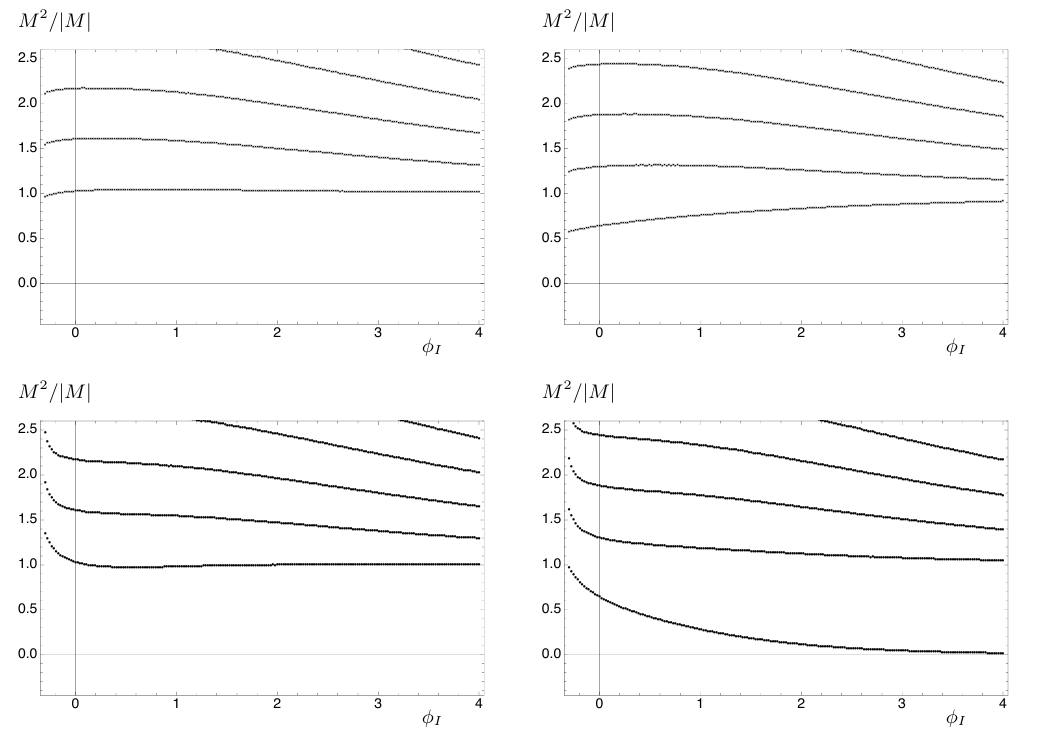
Figure 6 . Mass spectrum, with M 2 = − q 2 , of the spin-1 particles coming from the 2 -forms in five dimensions, as a function of the parameter φ , and normalised to the lightest tensor mode. The I markers are chosen to match the representations under SO(4) . Left to right and top to bottom: the four B , the four X , B , and X . Numerical calculations use ρ µν 5 µ 5 µν ¯ β µ ¯ β